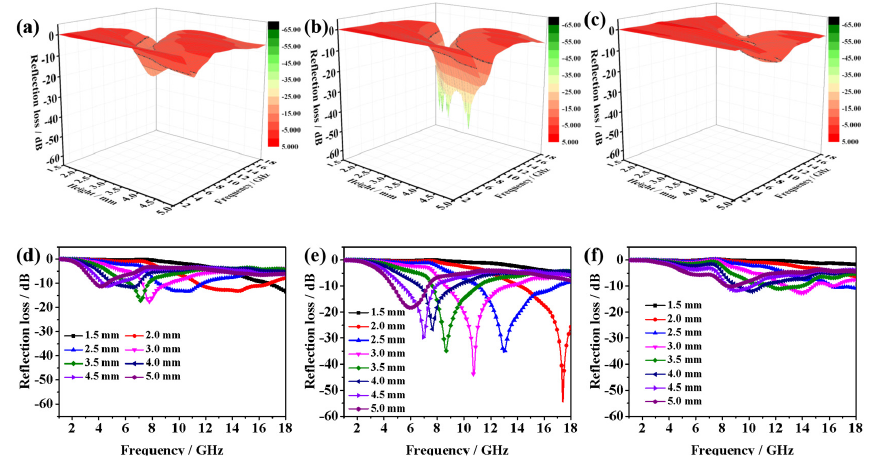
Figure 6. Three dimensional reflection loss values of the CoS 2 /paraffin composites with different contents under varied thicknesses (1.5–5.0 mm) in the frequency range of 1–18 GHz: ( a , d ) 10 wt%, ( b , e ) 20 wt%, ( c , f ) 30 wt%.